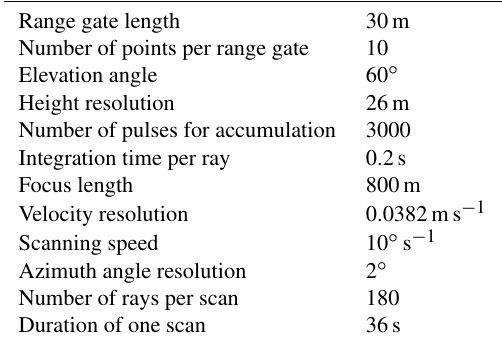
Table 2. Measurement parameters.